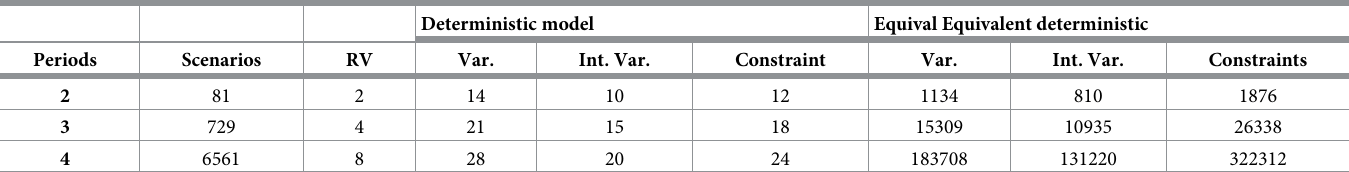
Table 5. Comparison of how the size of the problem increases with respect to the number of periods for Model-I and Model-II (R.V. denotes random variables, Var. denotes variables, and Int. Var. denotes integer variables). Own elaboration. Deterministic model